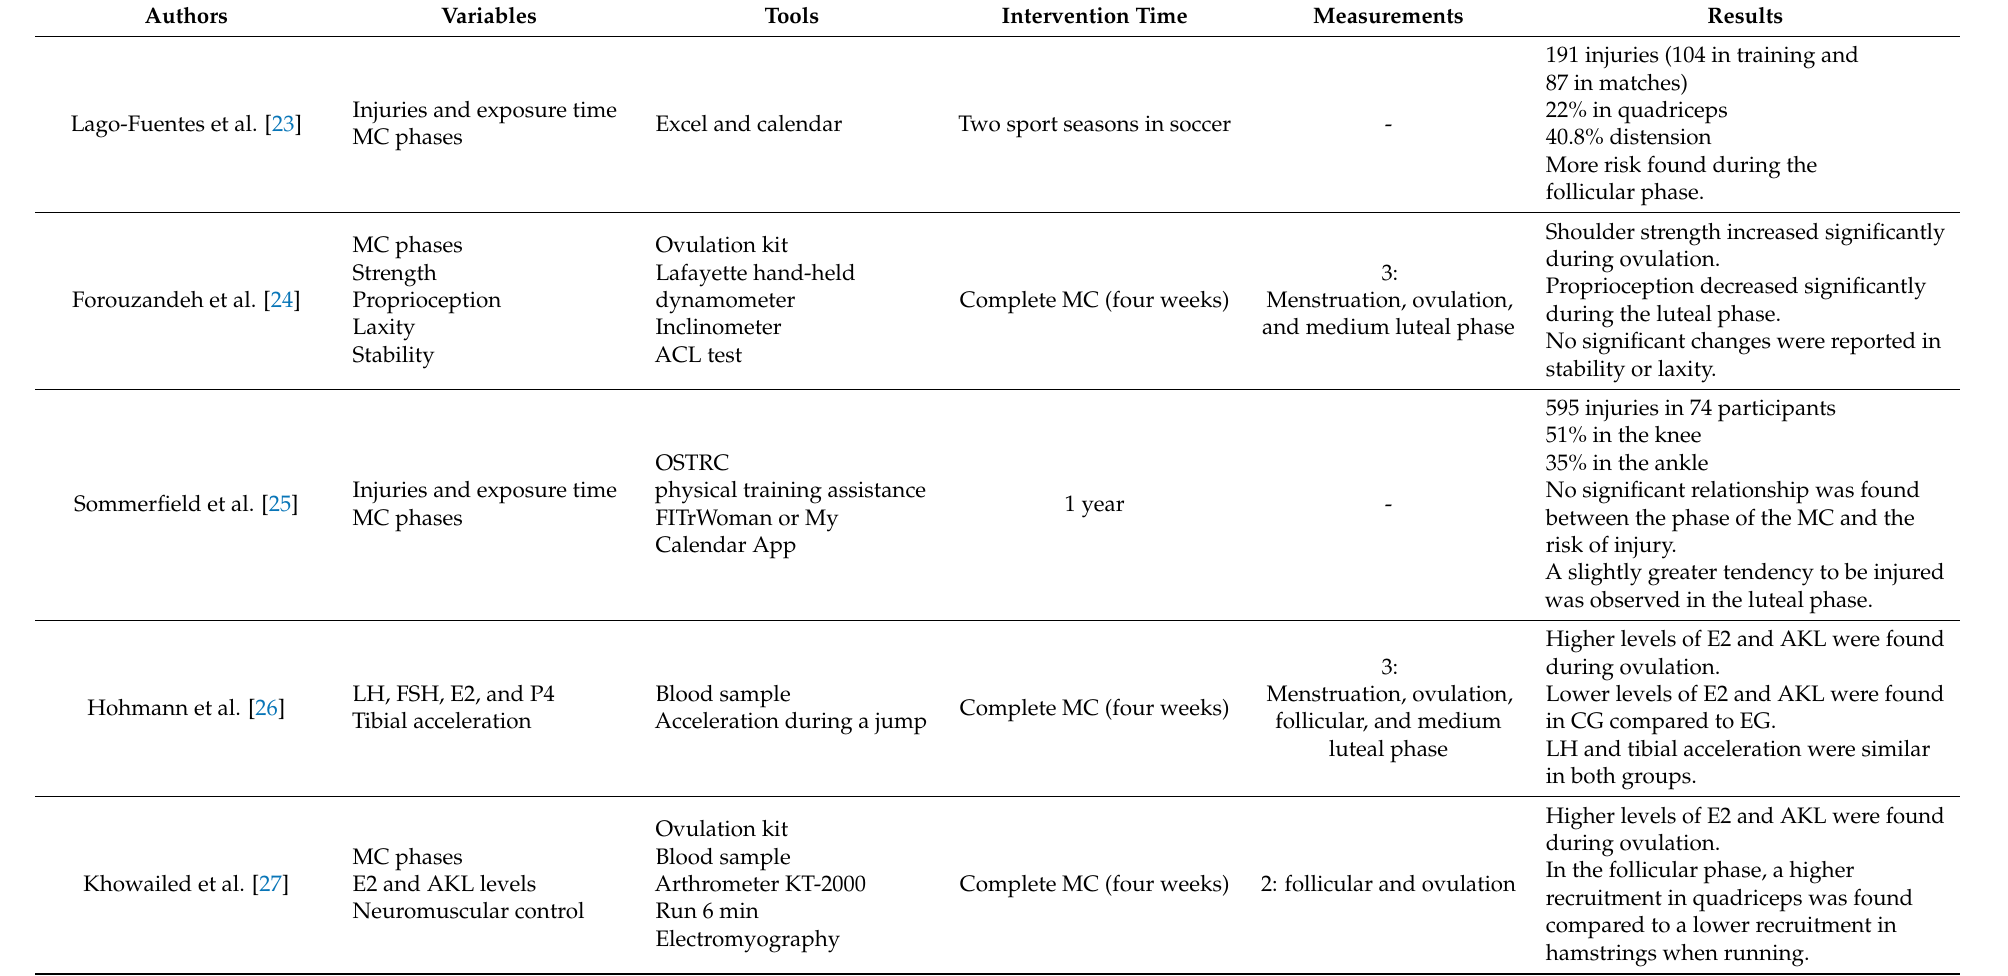
Table 3. Variables of studies and